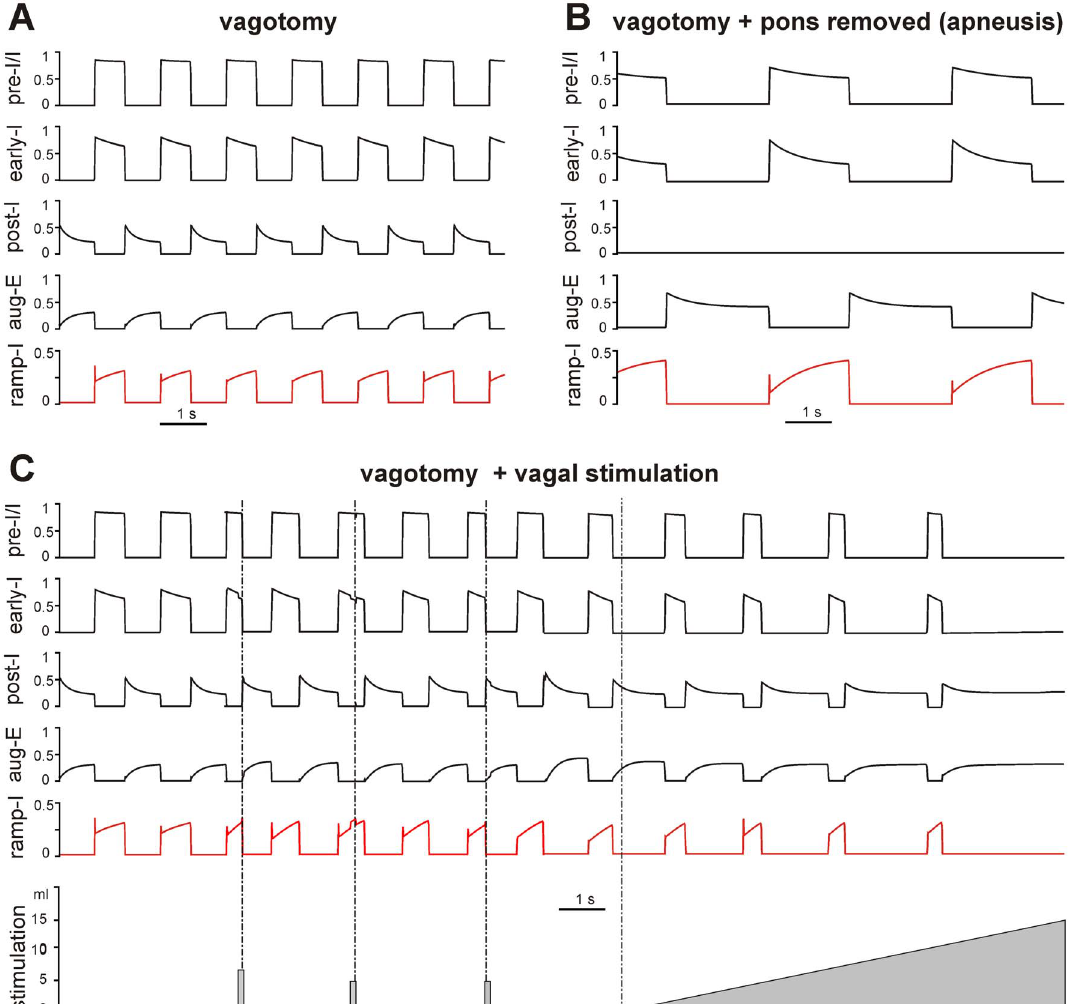
Figure 3. Perturbations of respiratory neural activity pattern by pontine removal and vagal stimulations. A . Model performance after vagotomy. B . Model performance after vagotomy and subsequent removal of pontine excitatory drive. Note the apneustic breathing pattern characterized by the significant increase in the duration of inspiration and slowing of the respiratory oscillations. C . Simulations of the effects of brief and continuous stimulation of mechanoreceptor afferents. The first stimulus (bottom trace, 7 ml of lung inflation) applied in the middle of the respiratory phase terminated the current inspiration. The second, reduced stimulus (5 ml) applied at the same phase was unable to terminate inspiration. The third stimulus of the same size as the second one (5 ml) applied later in inspiration terminated the inspiratory phase. Finally, continuous linearly increasing stimulation was applied. This stimulation shortened inspiration and prolonged expiration and then produced expiratory ‘‘apnea’’, when all inspiratory neurons were inhibited by continuously active expiratory